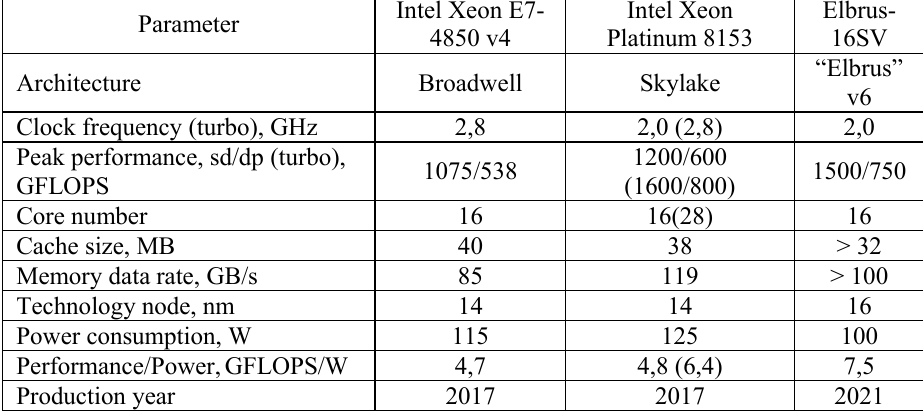
Table 1. Performance comparison between Elbrus and Intel processors